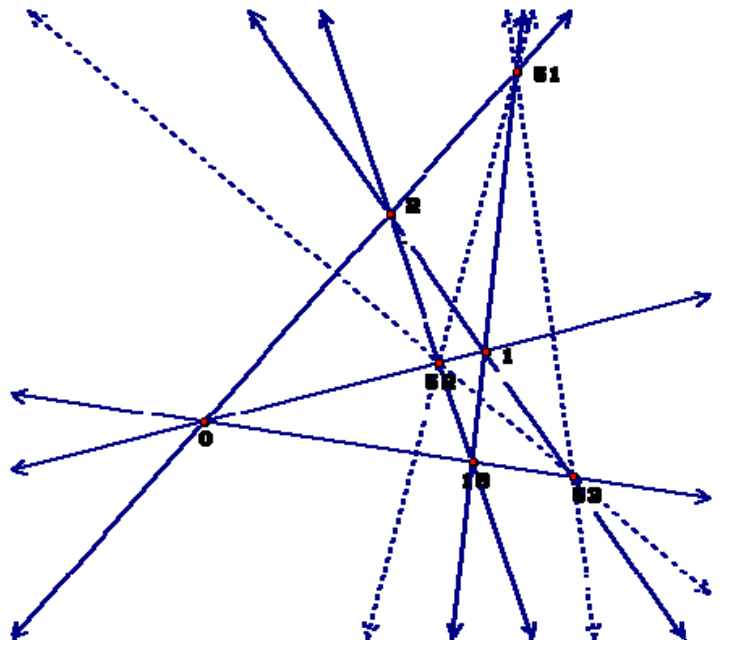
Figure 1. The Reference quadrangle.